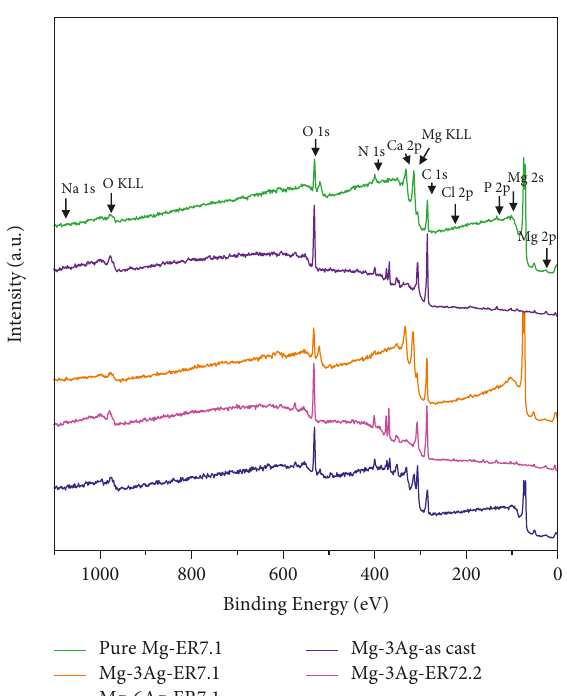
Figure 7: XPS results of the sample surfaces after an immersion test for 16 days.